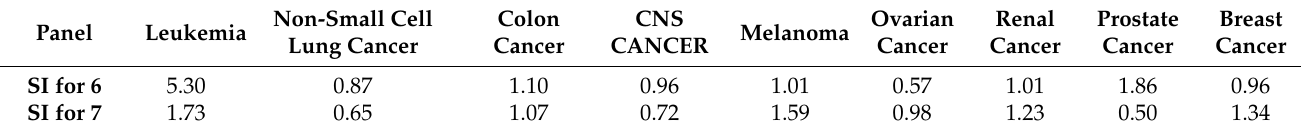
Table 3. Selectivity of compounds 6 and 7